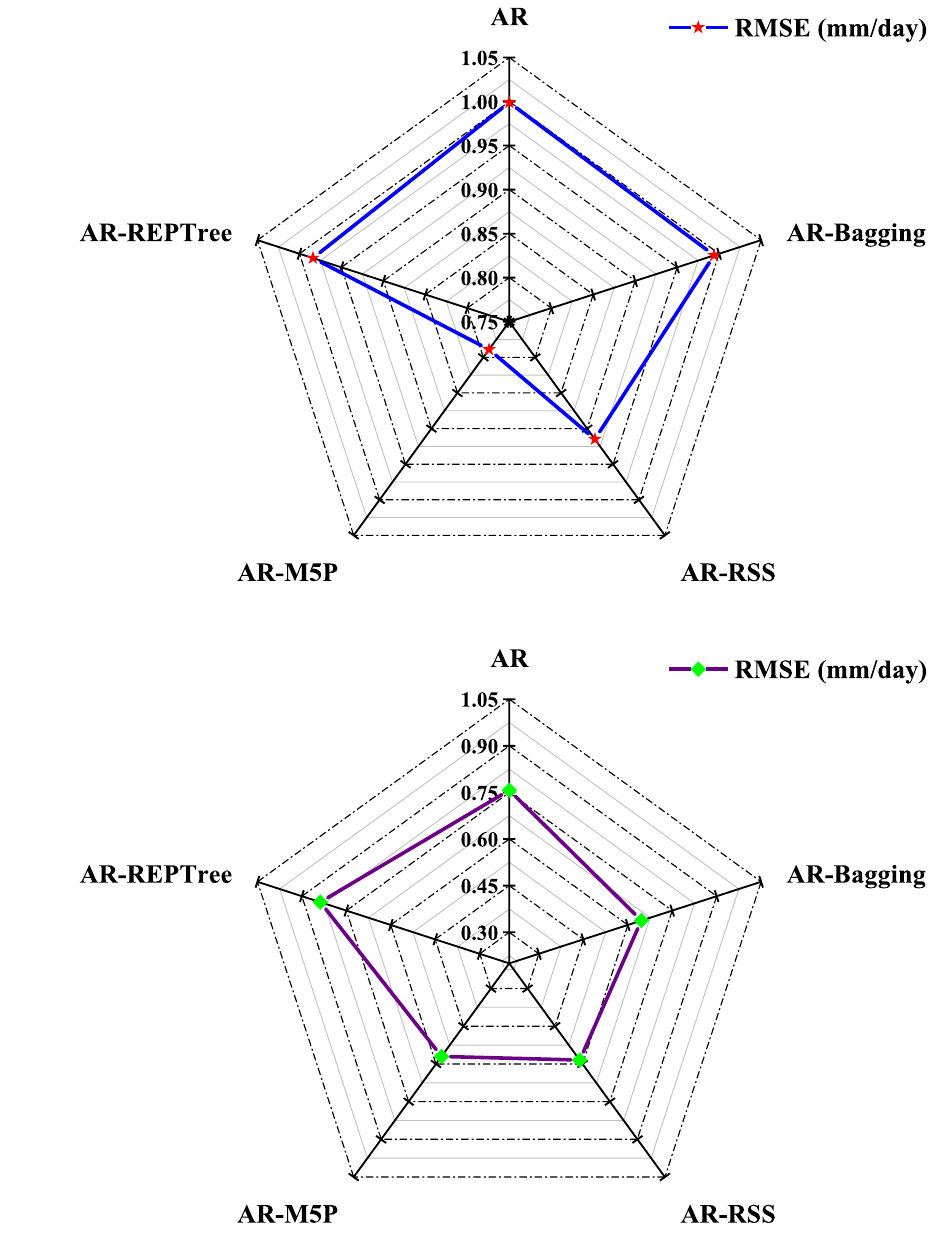
Fig. 6 Radar charts display the best value of RMSE for AR, AR-bagging, AR-RSS, AR- M5P, and AR-REPTree models during testing at Faisalabad station